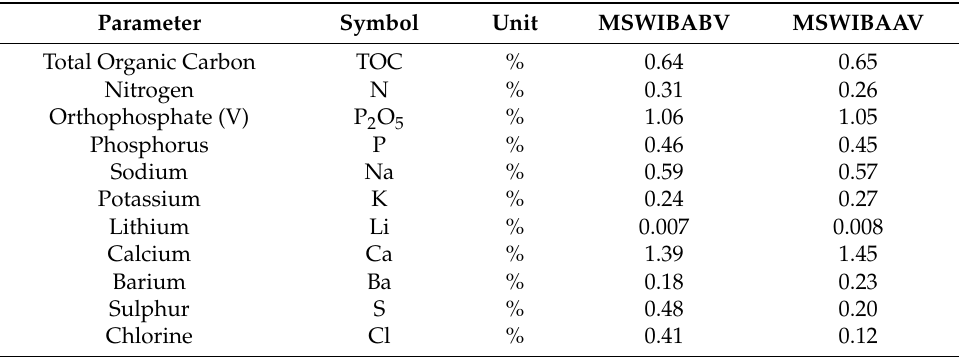
Table 4. Macroelements in slags [18–23].